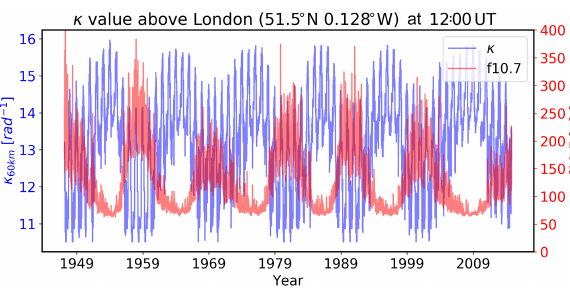
Figure 9. Solar cycle dependence of κ for a fixed location (London), tangent height (60km) and local time (12:00UT). 1sfu = 10 − 22 Wm − 2 Hz − 1 . Table 4. Solar cycle test parameters.